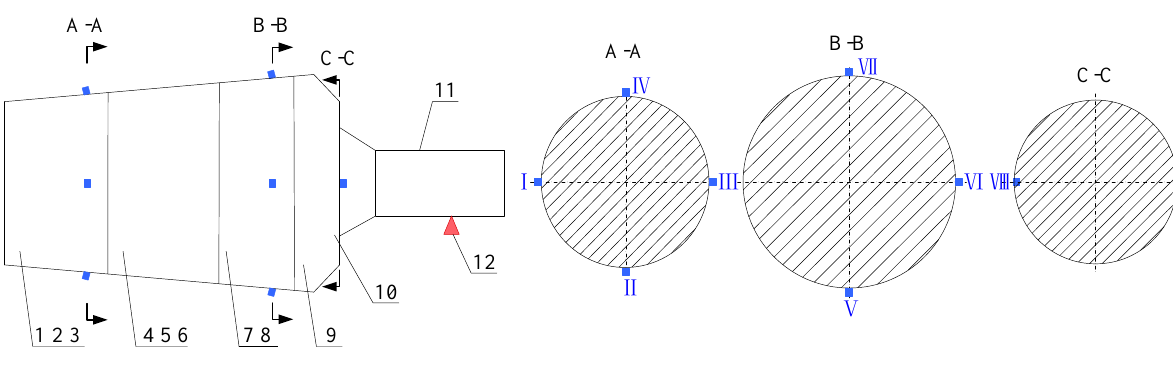
Figure 11. The structure of the aero-engine rotor and locations of the sensors: 1 – 9 : the first-ninth disk, 10 : shaft, 11 : location of the exciter, A-A, B-B, C-C: sections of sensor locations, Ⅰ – Ⅷ : locations of the